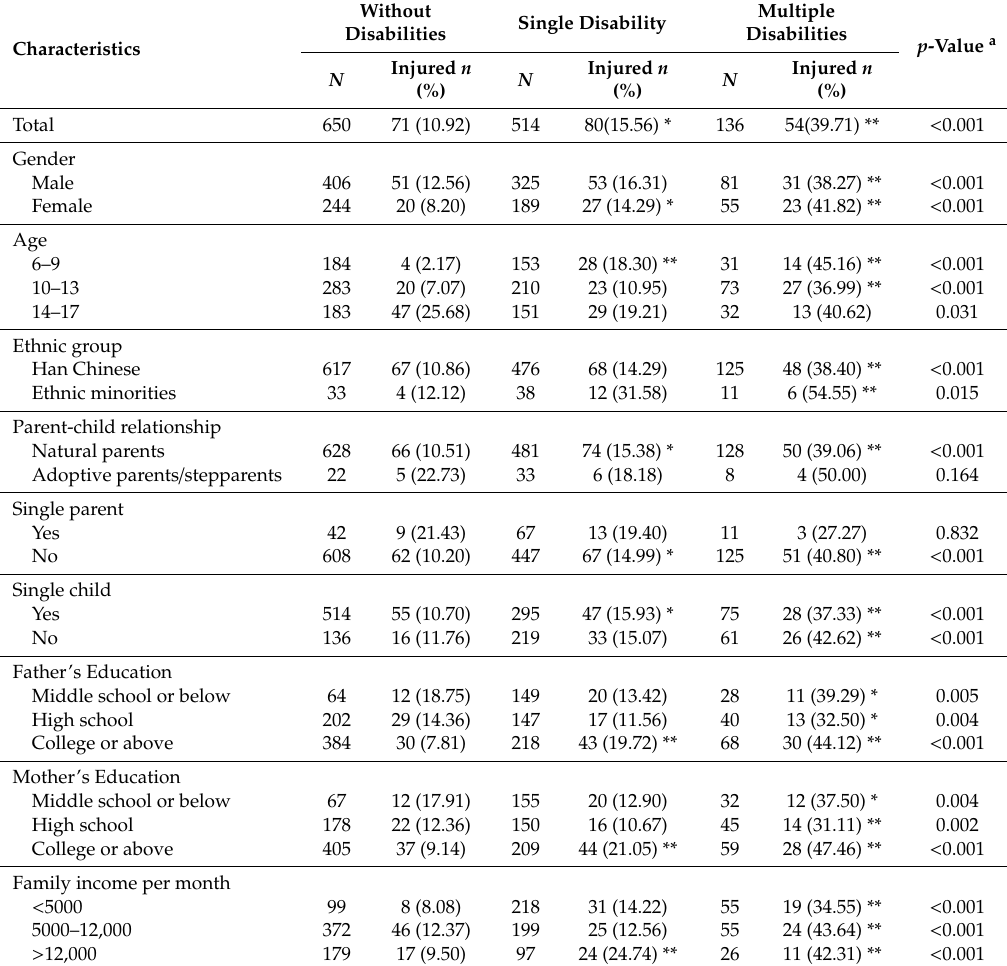
Table 1. Rates of deliberate self-harm (DSH) among children with a di ff erent disability status by selected sociodemographic factors in Beijing,